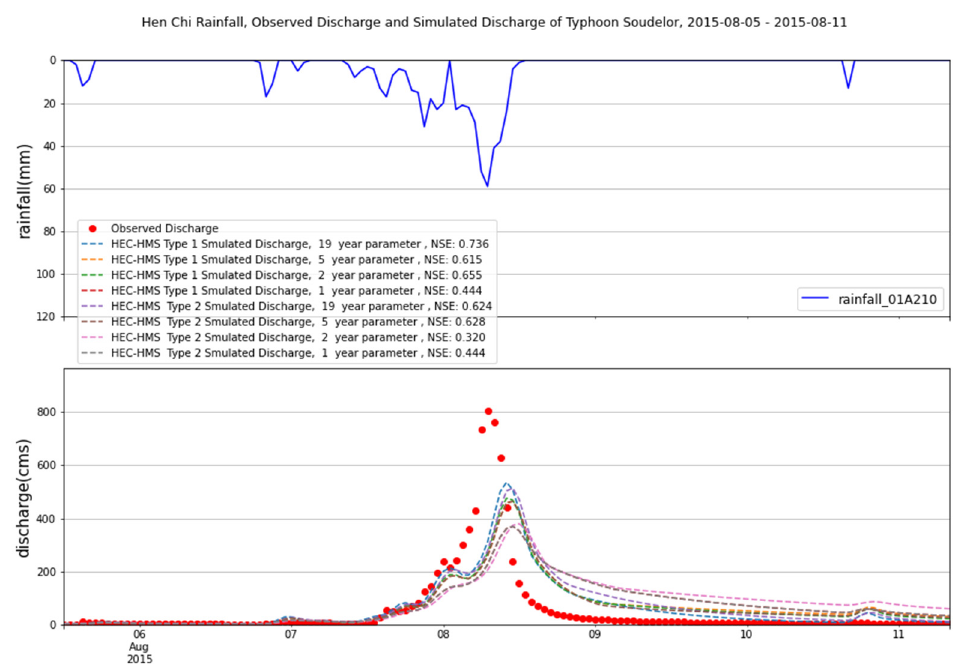
Figure 5. The measured rainfall time series (upper panel) and their corresponding rainfall-runoff simulations (lower panel) of the HEC-HMS model using different parameter optimization approaches for Typhoon Soudelor.